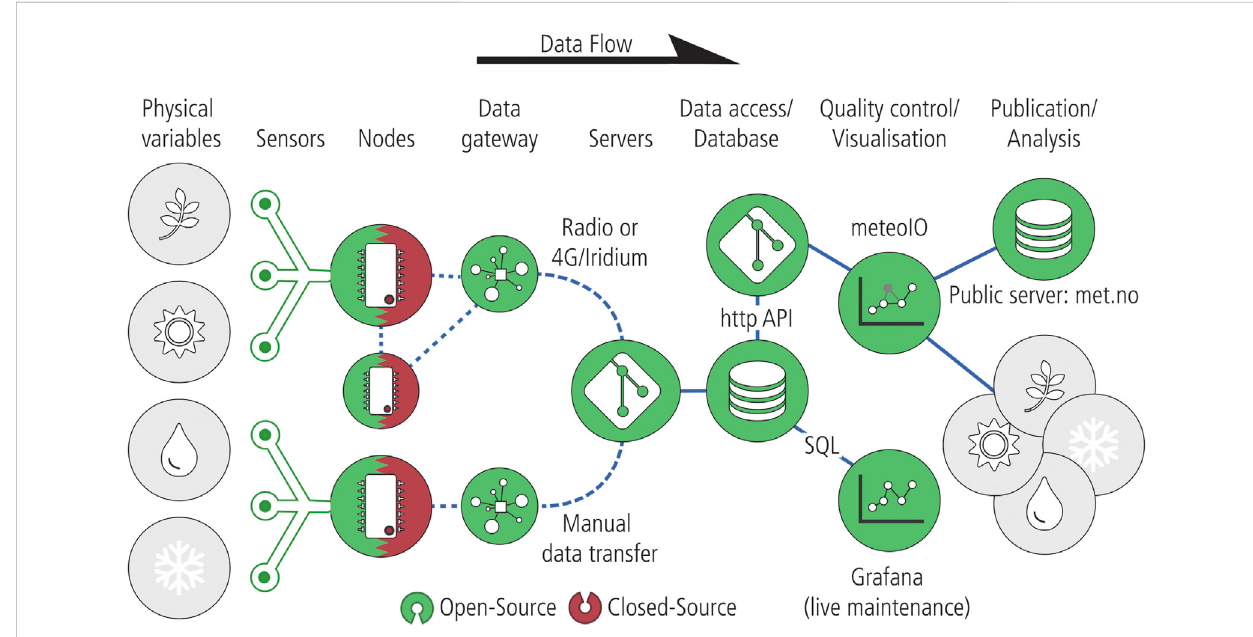
FIGURE 2 Overall architecture of the full-stack data pipeline designed and built to sample, transport, manage, store, visualize and disseminate data. This architecture is almost fully based on Open-Source technology (green), with an exception in this setup of a closed source microprocessor hardware motherboard